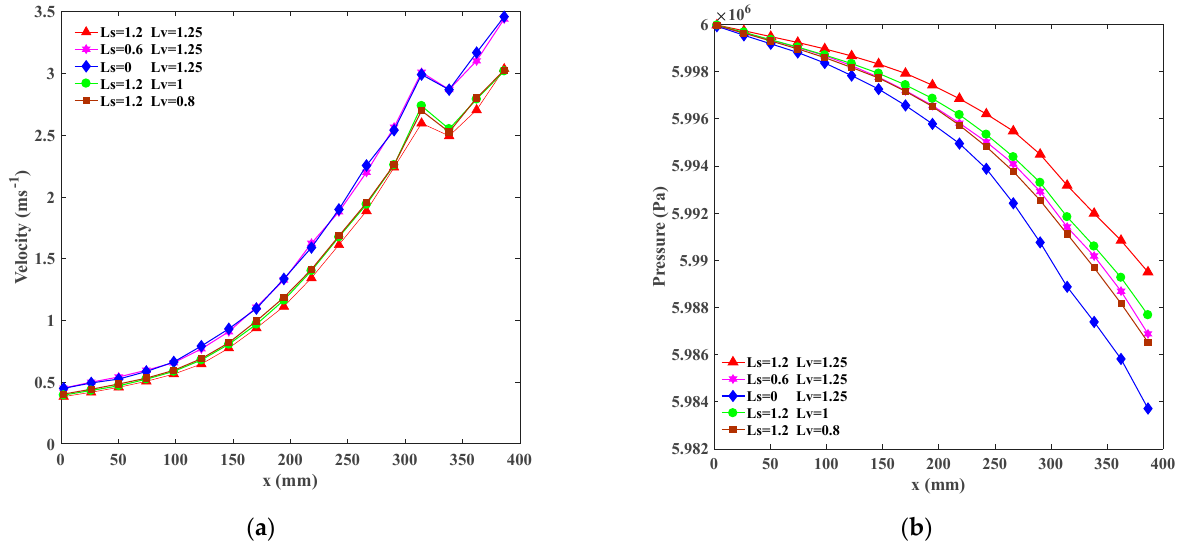
Figure 8. The average velocity and average pressure of the local cross section along the channel: ( a ) average velocity; ( b ) average pressure.